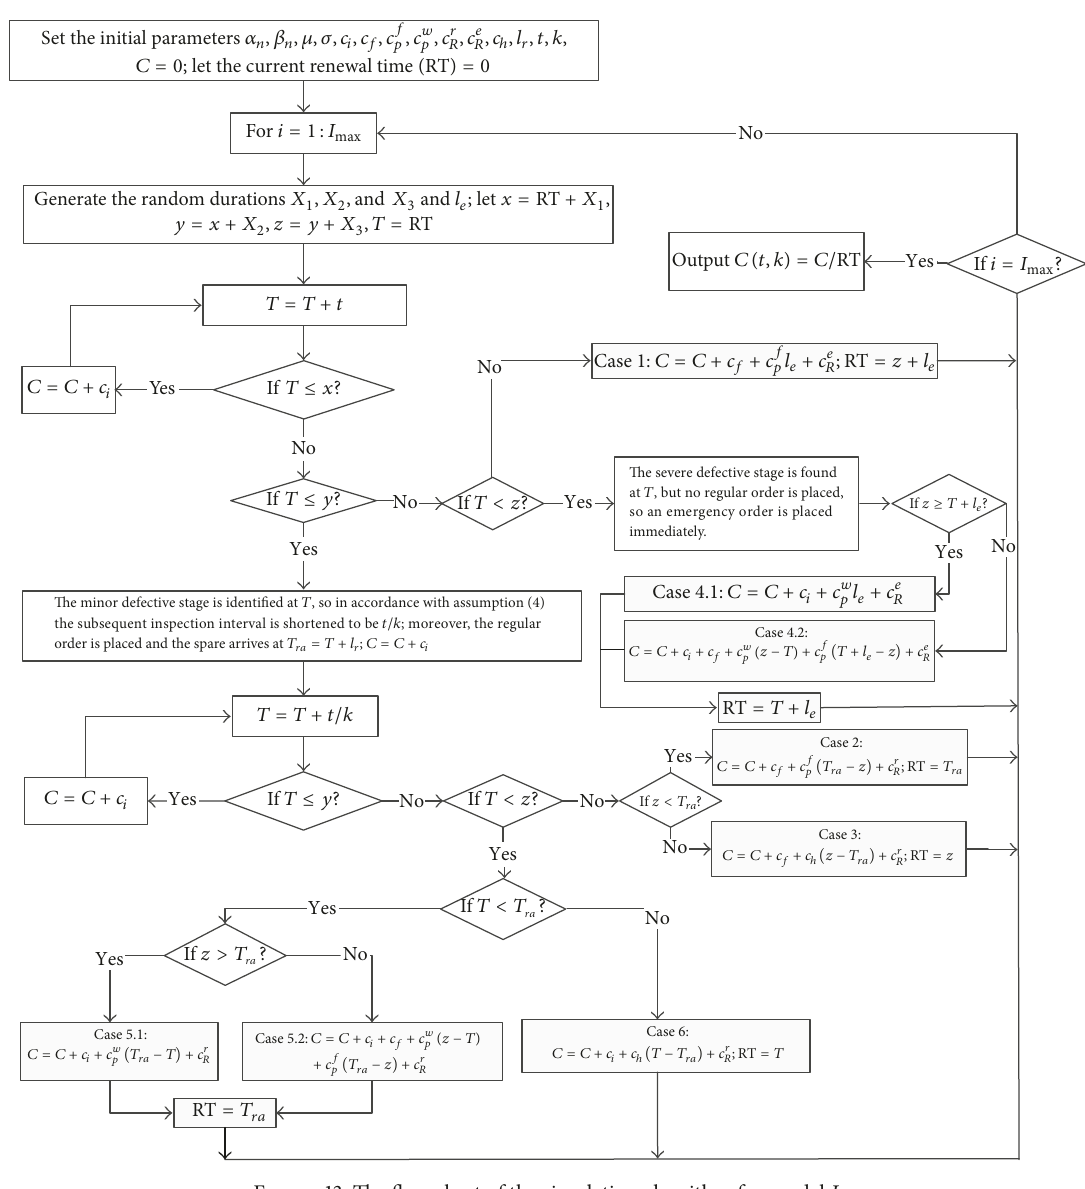
Figure 13: The flow chart of the simulation algorithm for model 𝐼